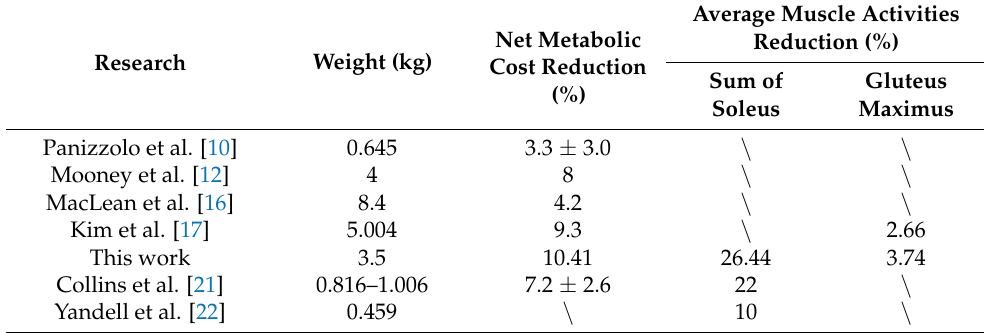
Table 2. Comparison of popular portable